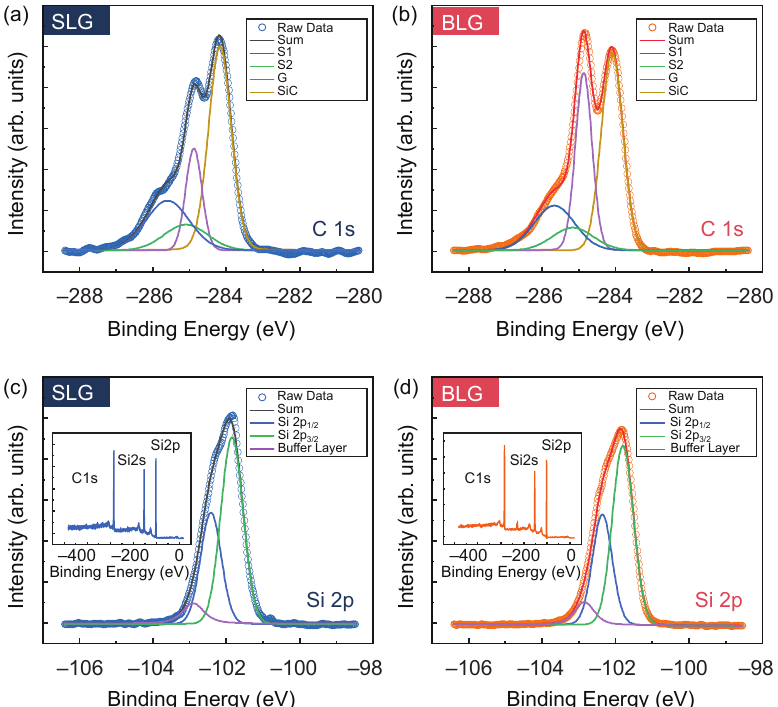
Figure 4. Chemical bonding spectra measured via XPS. ( a , b ) High resolved C 1s core-level spectrum of SLG and BLG treated with nitrogen plasma, the spectrums contain the deconvolution of SiC √ √ substrate (marked as SiC), the (6 3 × 6 3)R30 ◦ buffer layer, and the graphene layers (marked as G). ( c , d ) High resolved Si 2p core-level spectrum of SLG and BLG treated with nitrogen plasma, the spectrums contain contributions from spin–orbit split doublets, and the bonding between buffer layer and Si-terminated surface of SiC. Insets in panels ( c , d ) are the wide range XPS spectra of SLG and BLG treated with nitrogen plasma,